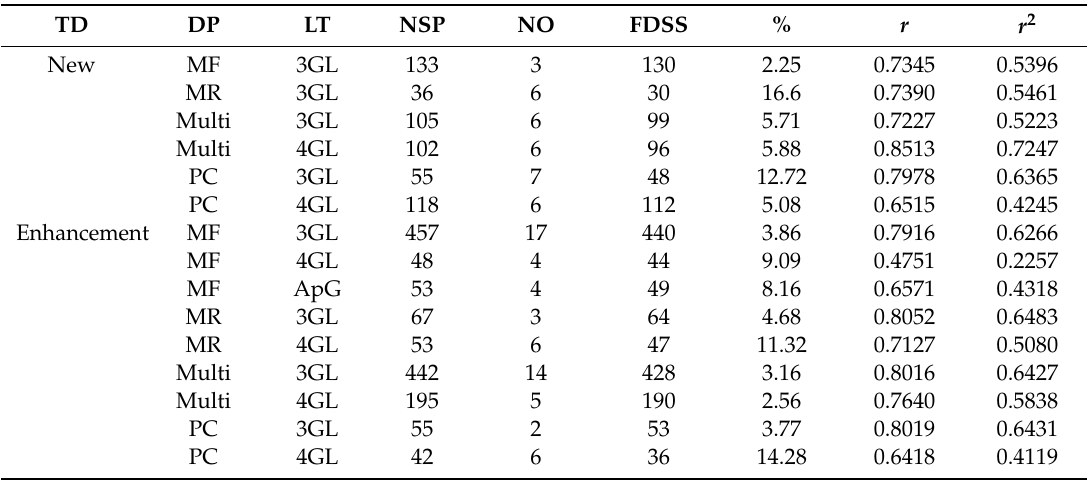
Table 6. Normalized data sets of software projects (NSP: number of software projects, NO: number of outliers, FDSS: final data set size).